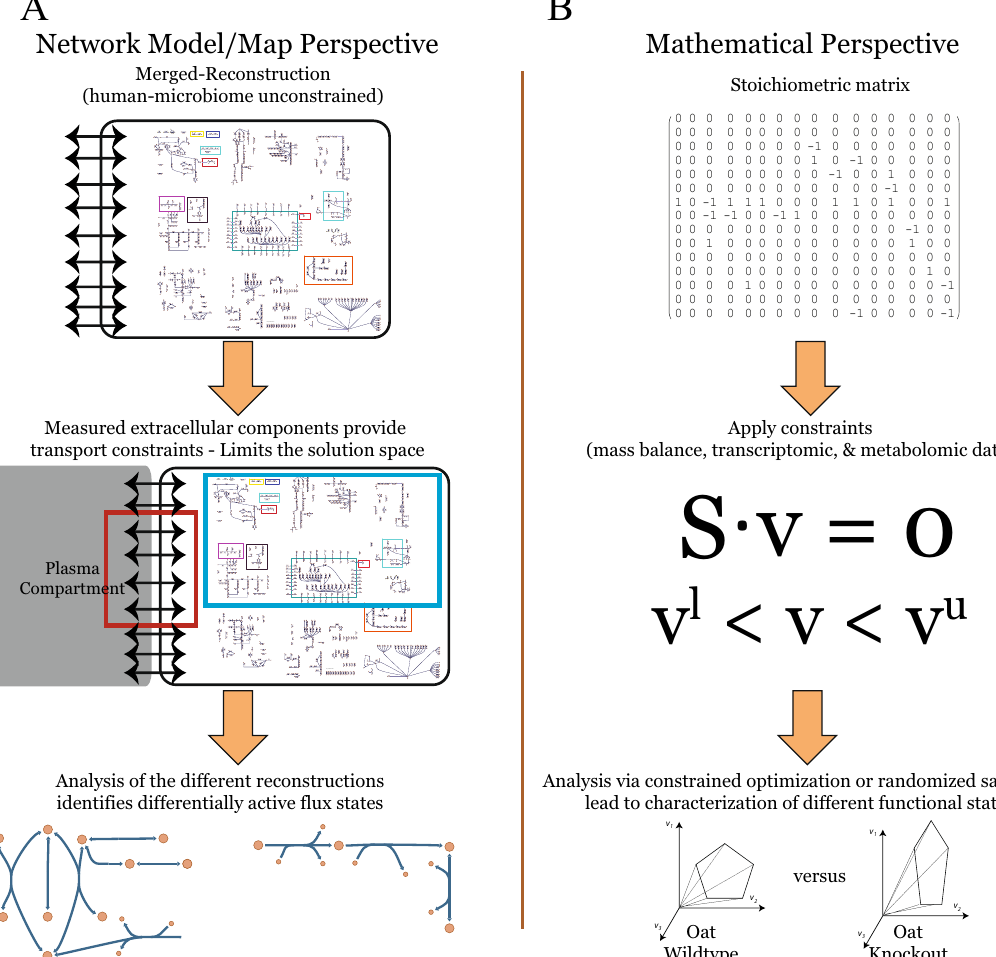
Figure 1. Data integration and analysis workflow. Panels ( A ) and ( B ) show two perspectives of the same process: the former outlines the graphical depiction of the integration and modeling approach; the